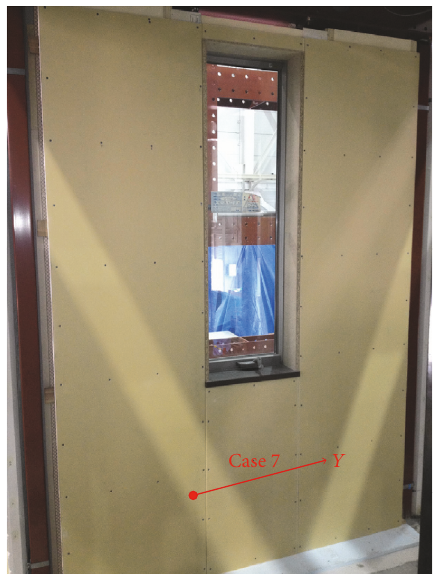
Figure 6: Internal view of Case 7 .